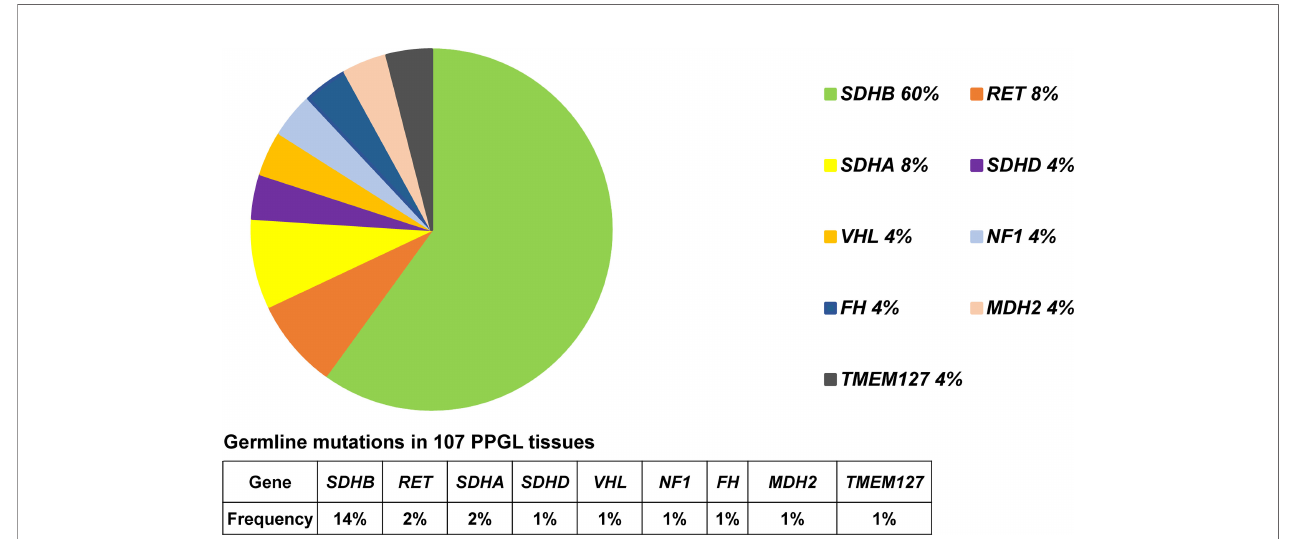
FIGURE 1 | Pie diagram showing the distribution of germline mutations in PPGL. Circular statistical graphic was used to illustrate the proportion of germline